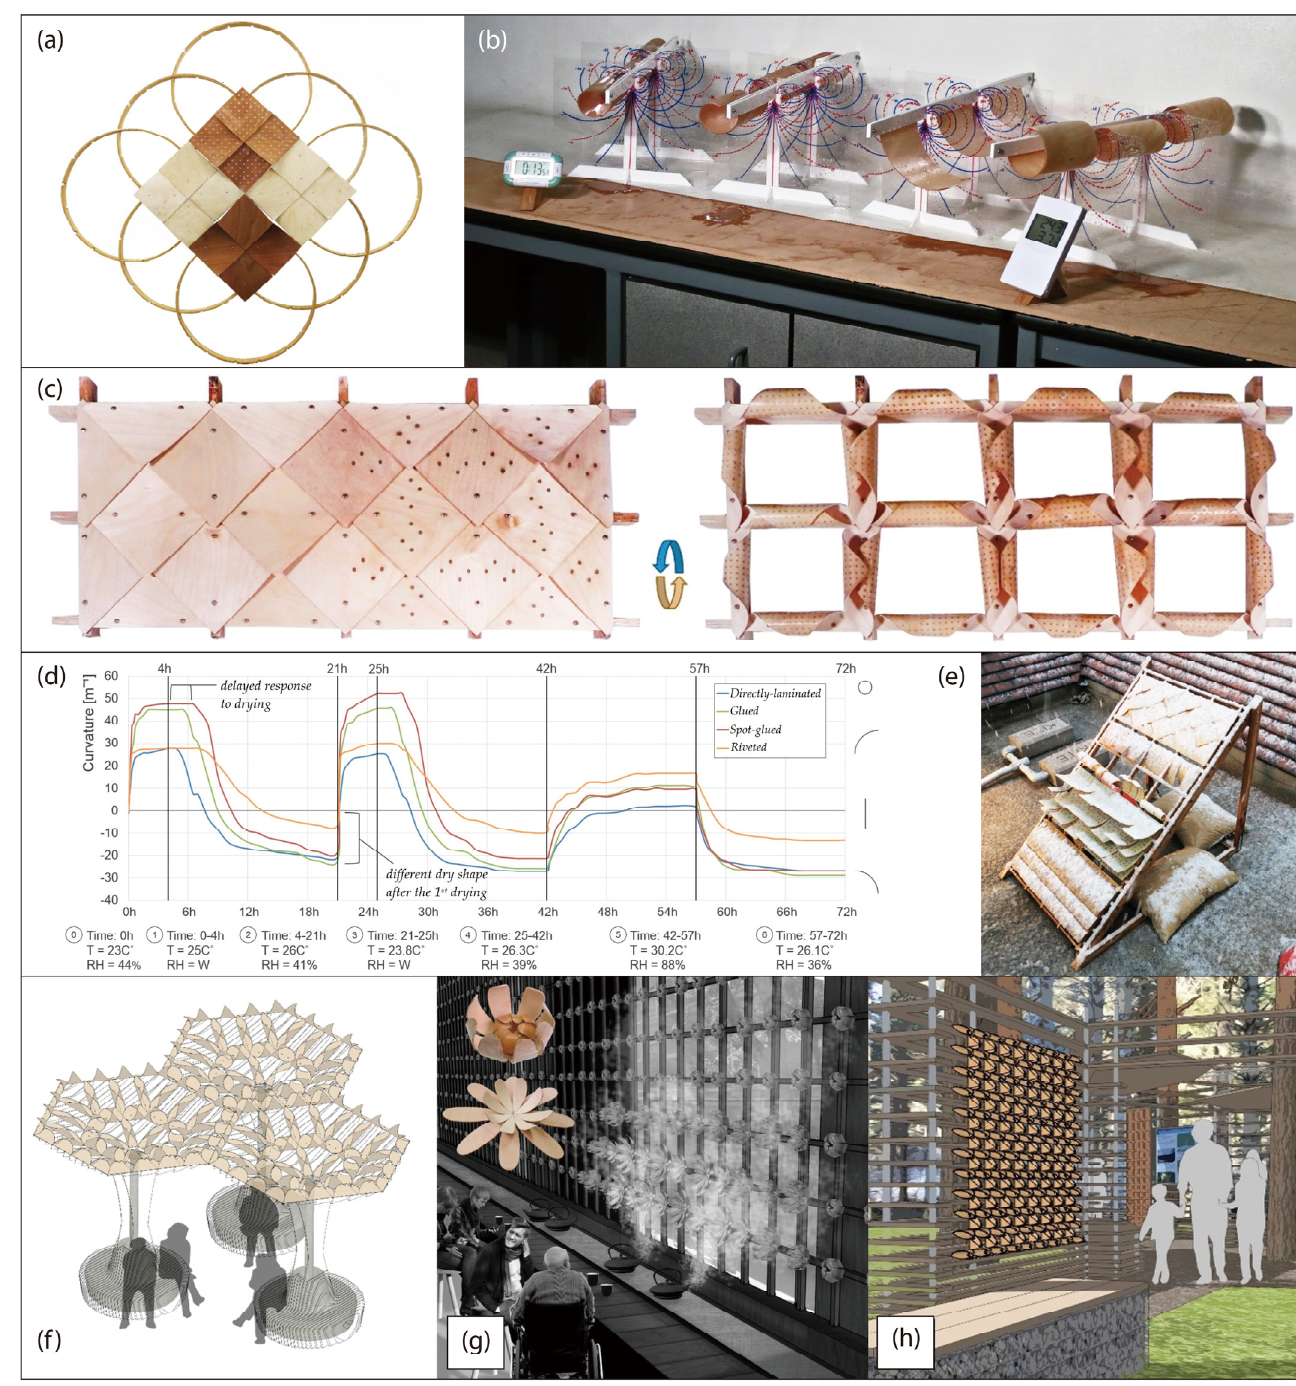
Figure 18. Programmable materials and responsive architectural design proposed by Holstov et al. [244]. ( a ) Material unit cells composed of different substrate materials. ( b ) Testing of the programmable behavior of material unit cells. ( c ) Example of deformation behavior of hygromorphic composite material. ( d ) Deformation response of hygromorphic composite material with different preprogrammed states. ( e ) Durability testing. ( f ) Modular outdoor seating design. ( g ) Indoor Adaptive System Design. ( h ) Other climate-responsive building design options.